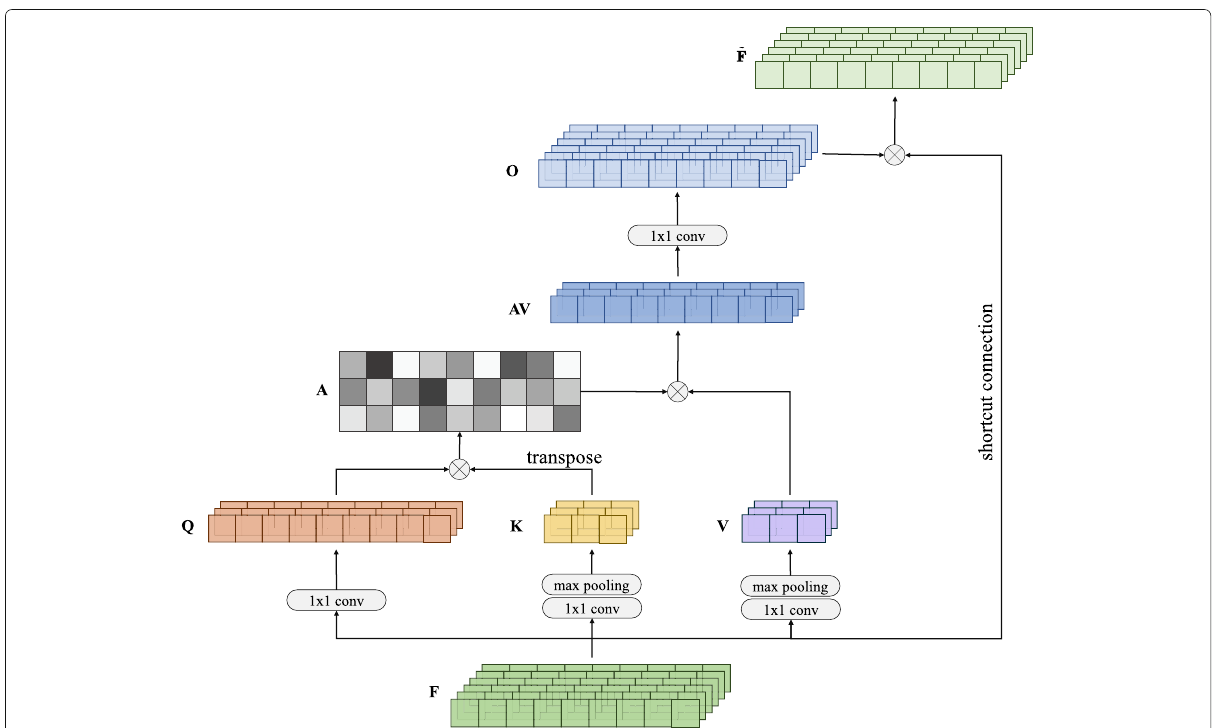
Fig. 2 Illustration of the application of self-attention mechanism in speech enhancement GANs with L = 9, C = 6, p = 3, and b =